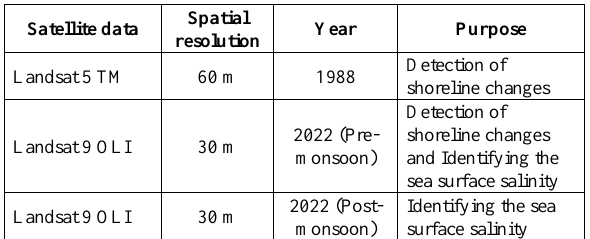
Table 1 . Description of the applied satellite data.